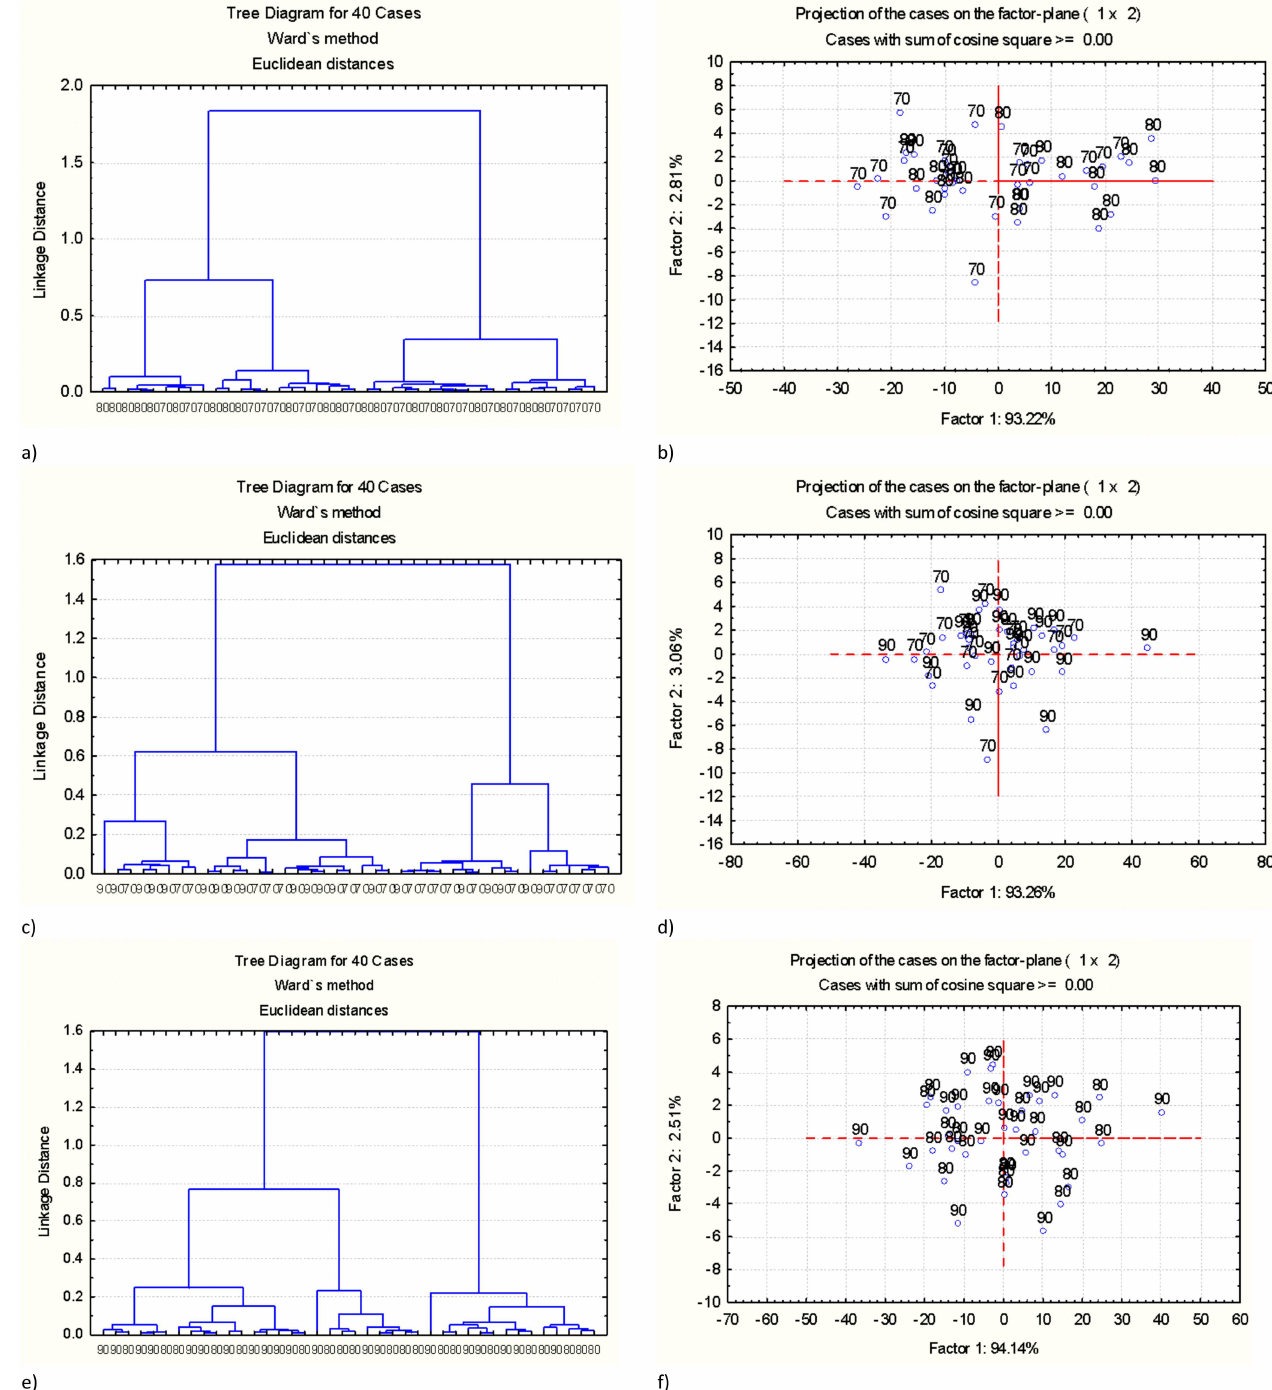
Fig 2. Multivariate molecular spectral analyses of protein fingerprint region at ca. 1718–1481cm -1 . Comparison of samples processedunder different temperatures using cluster analysis(cluster method: Ward’s algorithmand distancemethod: Euclidean)and principalcomponentanalysis [Scatter plots of the 1st principalcomponents(PC1) vs. the 2nd principalcomponents(PC2)]: (a) CLA: samples conditionedat 70˚C (70) vs. samples conditioned at 80˚C (80); (b) PCA: samples conditioned at 70˚C (70) vs. samples conditioned at 80˚C (80); (c) CLA: samples conditioned at 70˚C (70) vs. samples conditioned at 90˚C (90); (d) PCA: samples conditioned at 70˚C (70) vs. samples conditioned at 90˚C (90); (e) CLA: samples conditioned at 80˚C (80) vs. samples conditioned at 90˚C (90); (f) PCA: samples conditionedat 80˚C (80) vs. samples conditionedat 90˚C